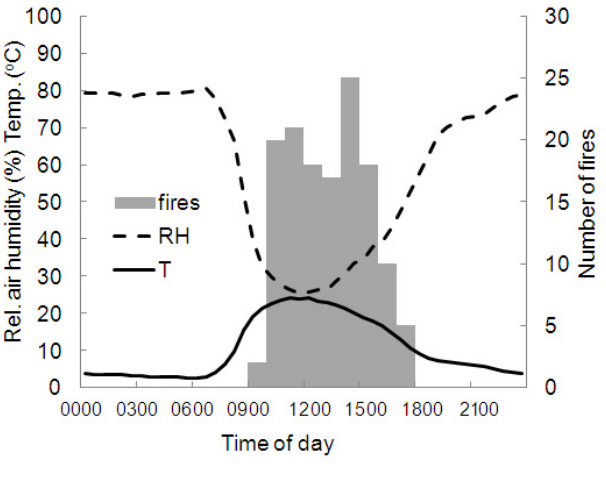
Fig. 7 . Temporal distribution of the observed heathland fires. The curves illustrate the average relative air humidity (RH) and temperature (T) for all days with at least one fire